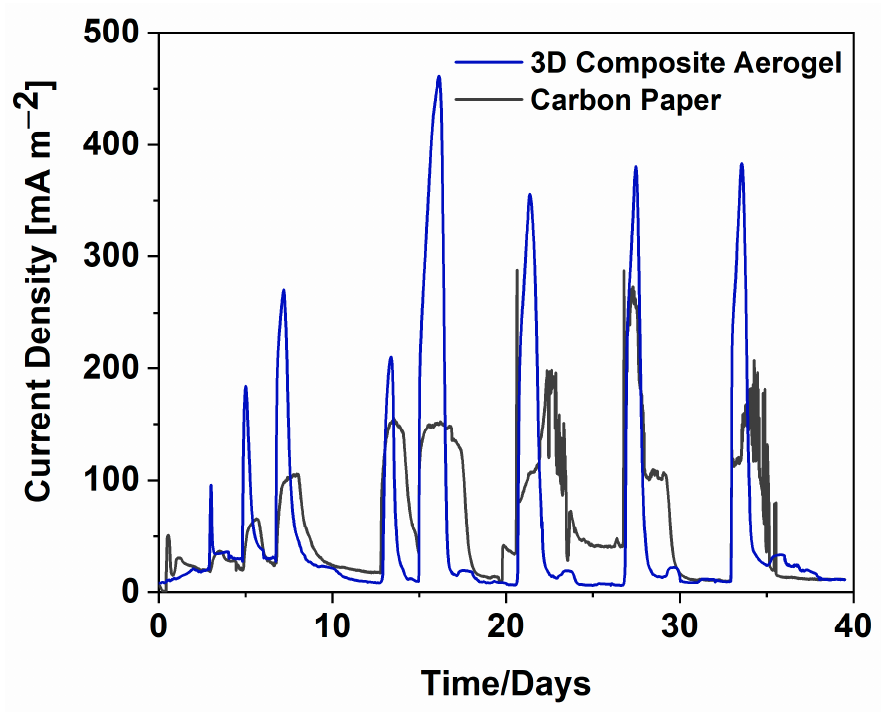
Figure 4. Current density trends represented as a function of time and normalized with respect to the geometric area.